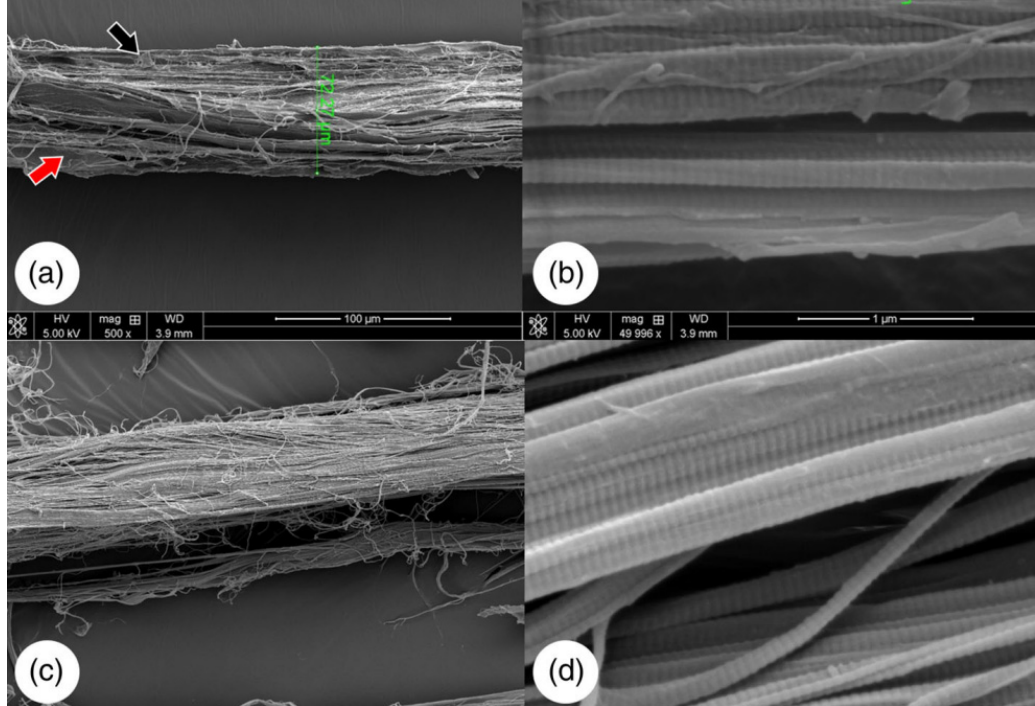
Figure 7. SEM images of native bovine tendon ( a,b ). The red and black arrows are pointing at cellular debris. Decellularized bovine tendon ( c , d ). Adapted from [50].